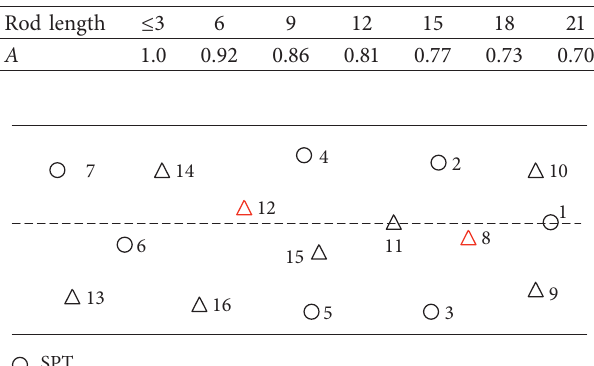
Figure 4: Layout of SPT and CPT measuring